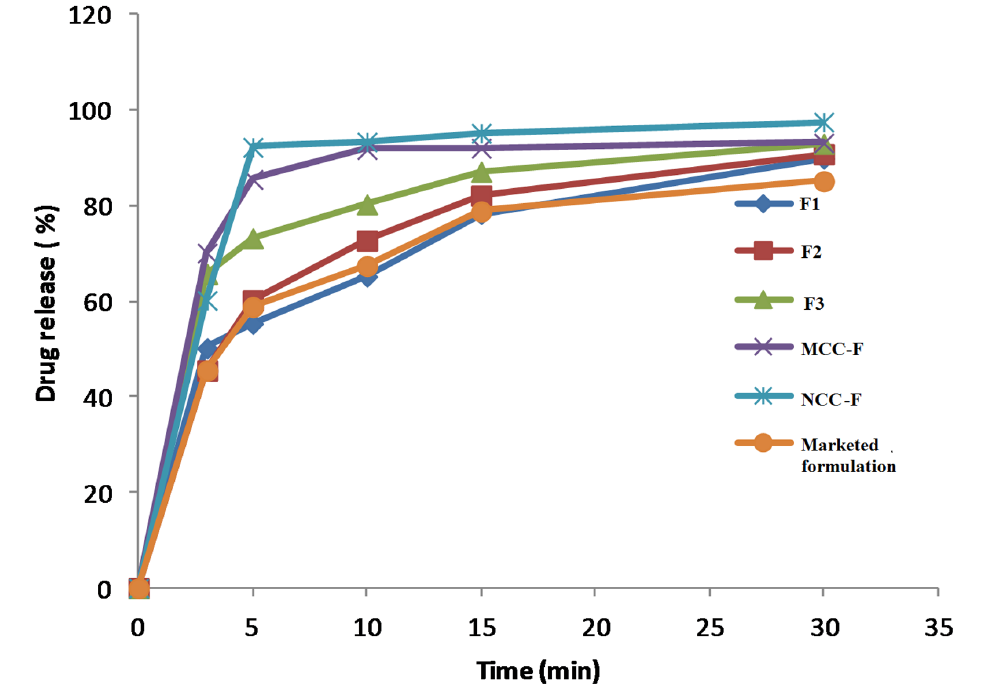
FIGURE 9 - In-vitro dissolution graphs for cellulose combined ODF formulations. All the results mentioned as mean ± SD,